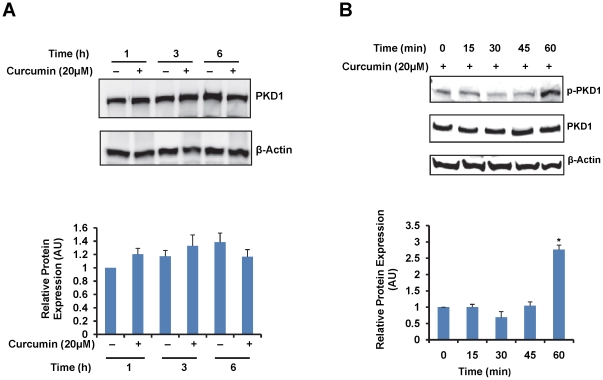
Curcumin activates PKD1.A). Effect of curcumin on PKD1 levels. C4-2 cells were treated with 20 µM curcumin. At varying time points, the cells were harvested, and the lysates were resolved on SDS-PAGE, transferred onto a PVDF membrane and probed for total PKD1. β-actin was used as an internal loading control. The band intensities were densitometrically analyzed, normalized to β-actin levels and graphed. Curcumin treatment resulted in no marked change in PKD1 expression at 1, 3 and 6 h. B). Effect of curcumin on activation of PKD1. For determining the expression of activated/phosphorylated PKD1, blots were probed with phospho PKD1, total PKD1 and β-actin antibodies. The pPKD1 band intensity was normalized to total PKD1 levels and graphed. Curcumin treatment induced PKD1 activation/phosphorylation by 1 h, while no apparent changes were observed in the expression of total PKD1. Representative blots of three experiments are shown in the figure. AU- arbitrary units.